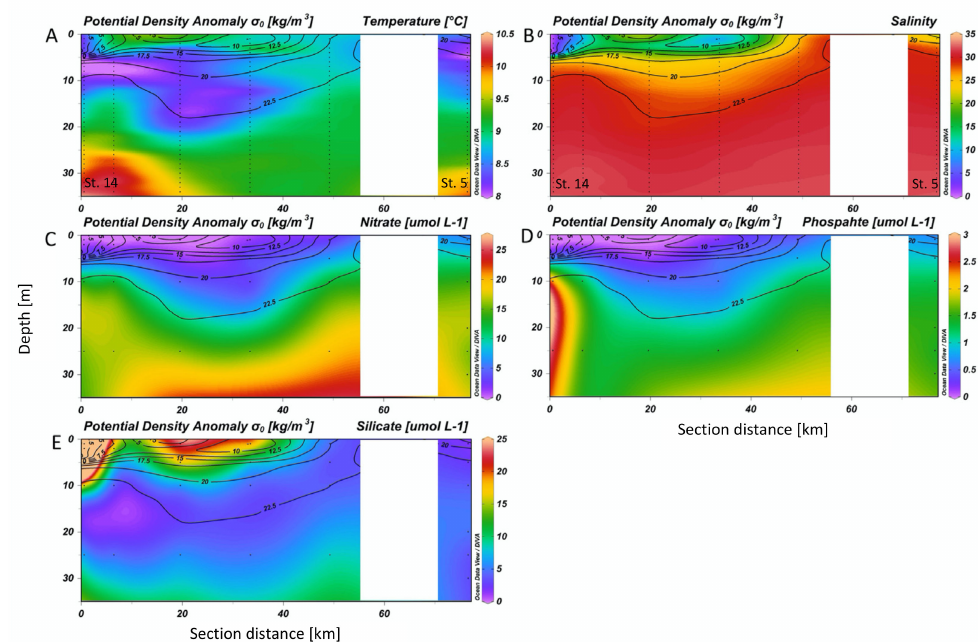
Figure 2. ( A ) temperature ( ◦ C), ( B ) salinity (PSU), ( C ) nitrate ( µ mol L − 1 ), ( D ) phosphate ( µ mol L − 1 ), and ( E ) silicate ( µ mol L − 1 ) spatial variability in an east-(Kruger channel)-to-west (Steffen fjord) transect. Surface water for the experiments was obtained from the marine-influenced station 5 and the estuarine station 14.